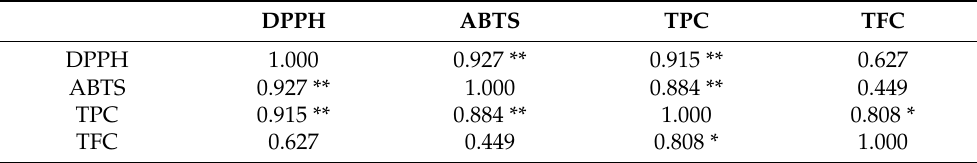
Table 1. Pearson ’ s correlation coefficient of TPC and TFC with antioxidant activity in the aqueous extract of A. angustiloba .